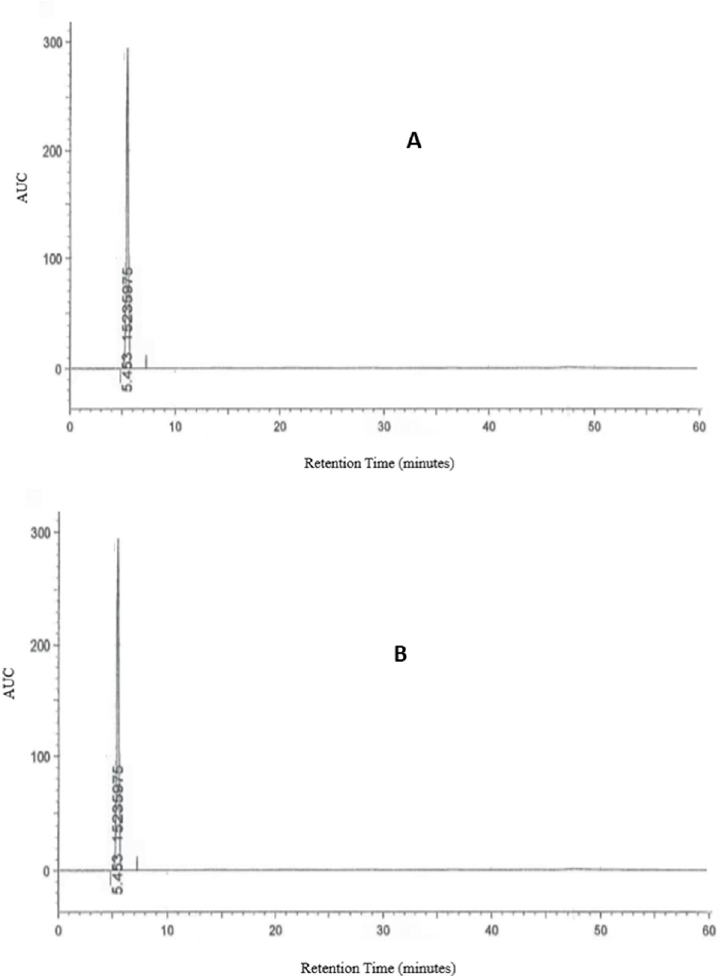
Fig 3. HPLC Chromatogram of SiP and its degradation products substance (A and B before and after magnification.